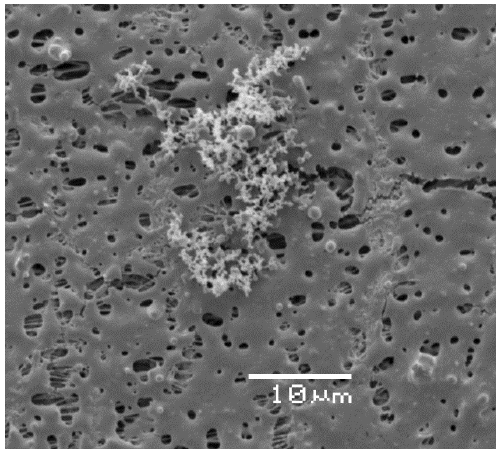
Figure 3. Scanning electron microscopy (SEM, uncoated, backscat- tered electron imaging, low vacuum) image of an aggregate on a Teflon filter from the higher-elevation, rural site (PEAV) on 18 September 2014.